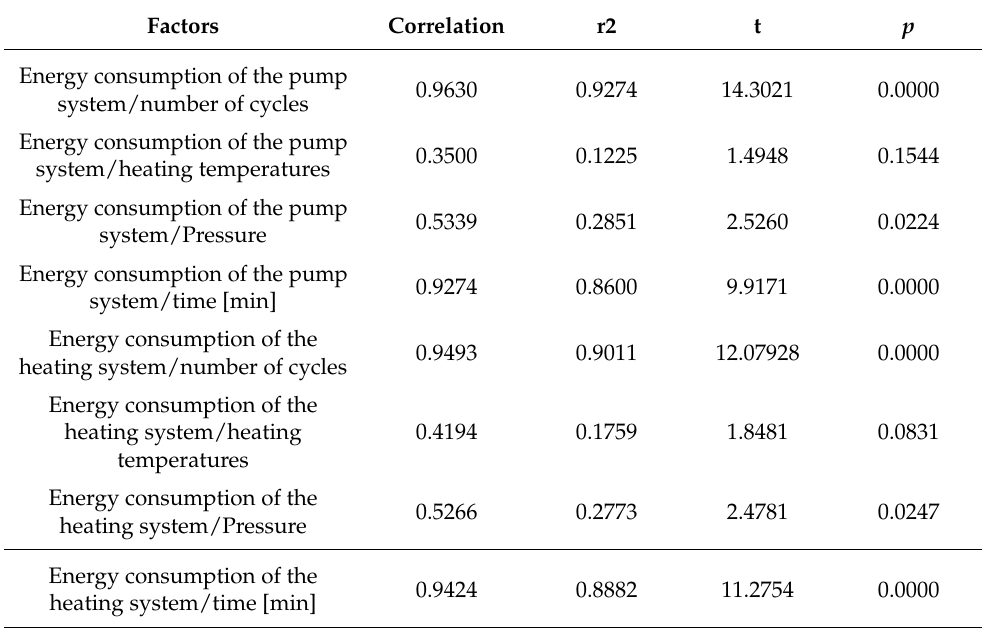
Table 2. Correlation